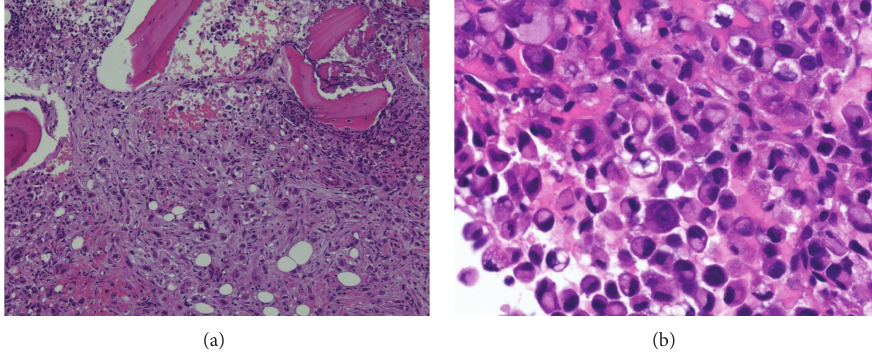
Figure 3: (a) Metastasis to the lumbar spine. Histologic sections of a core biopsy of the L3 vertebral body demonstrate near complete marrow replacement by a proliferation of malignant cells with associated fibrosis ((a), 10x). (b) Metastasis to the lumbar spine. On high power (40x), the infiltrate is comprised of signet ring cells morphologically identical to the gastric cardia biopsy (see Figure 4(b)).